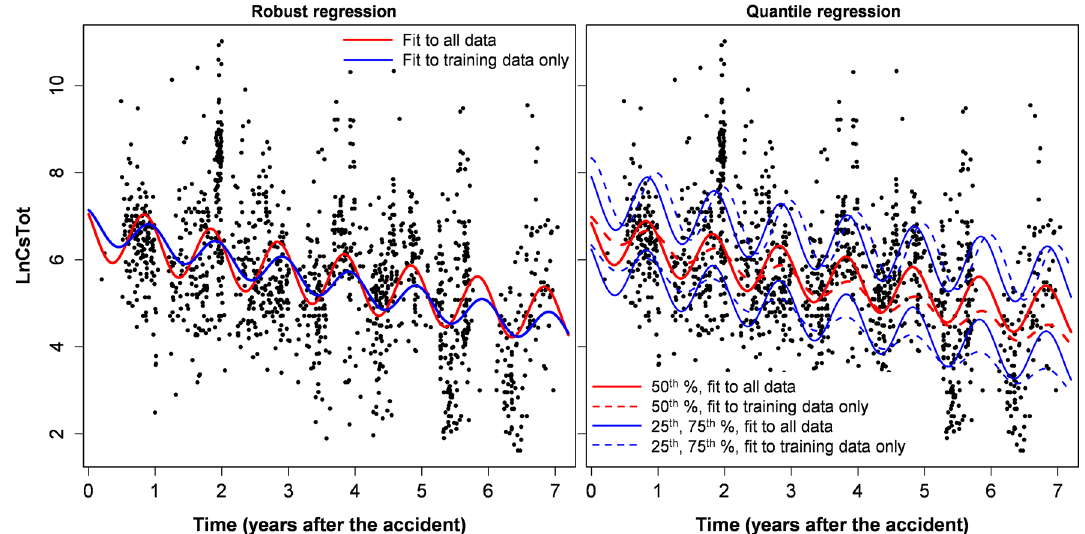
Figure 1. Robust and quantile regression analyses for wild boar ( Sus scrofa ) data. In this and the following figures, training data represent approximately ½ of the data set between 0 and ~ 3.5 years after the Fukushima accident, as described in the main text. The data points in both panels are the same, but some of them are obscured by the legend in the right panel. This figure was generated using R 4.0.3 software 21 .